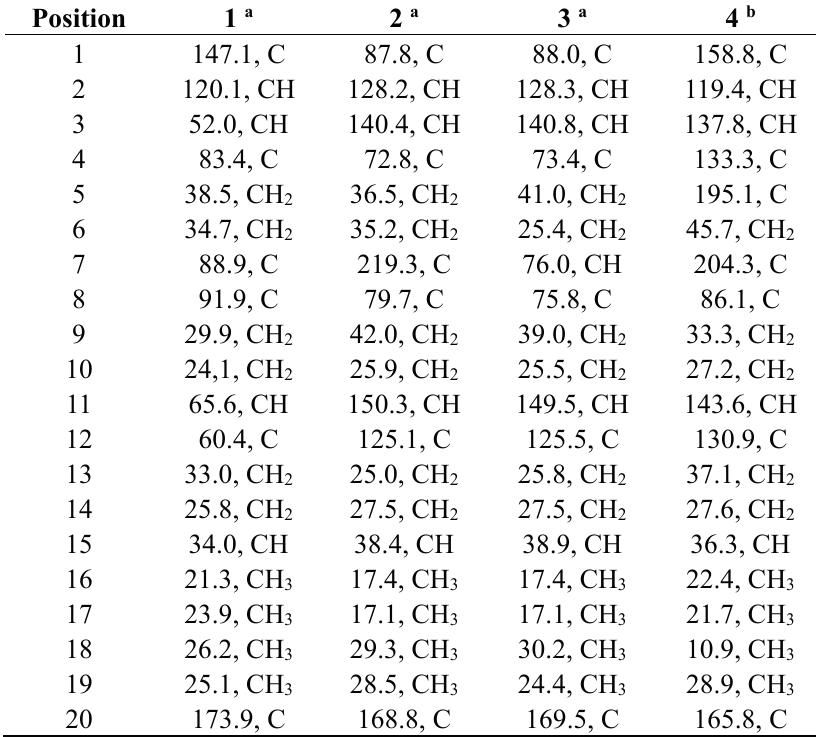
Table 2. 13 C-NMR spectroscopic data of 1 – 4 (100 MHz, δ in